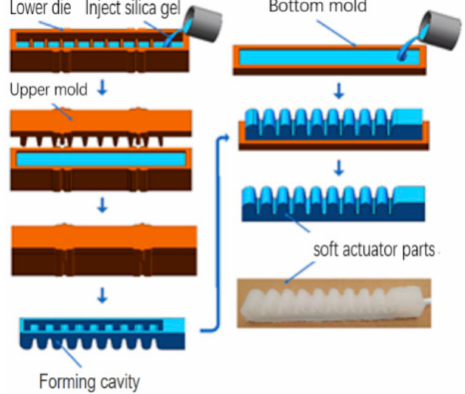
Figure 1. Casting molding process